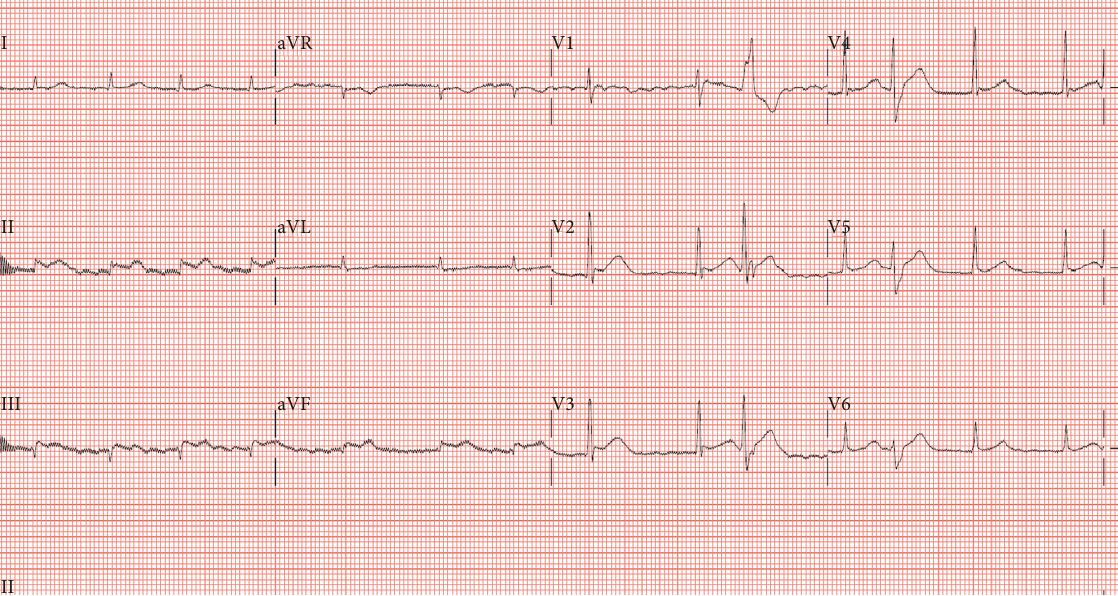
Figure 2: ECG showing ST elevation in inferior